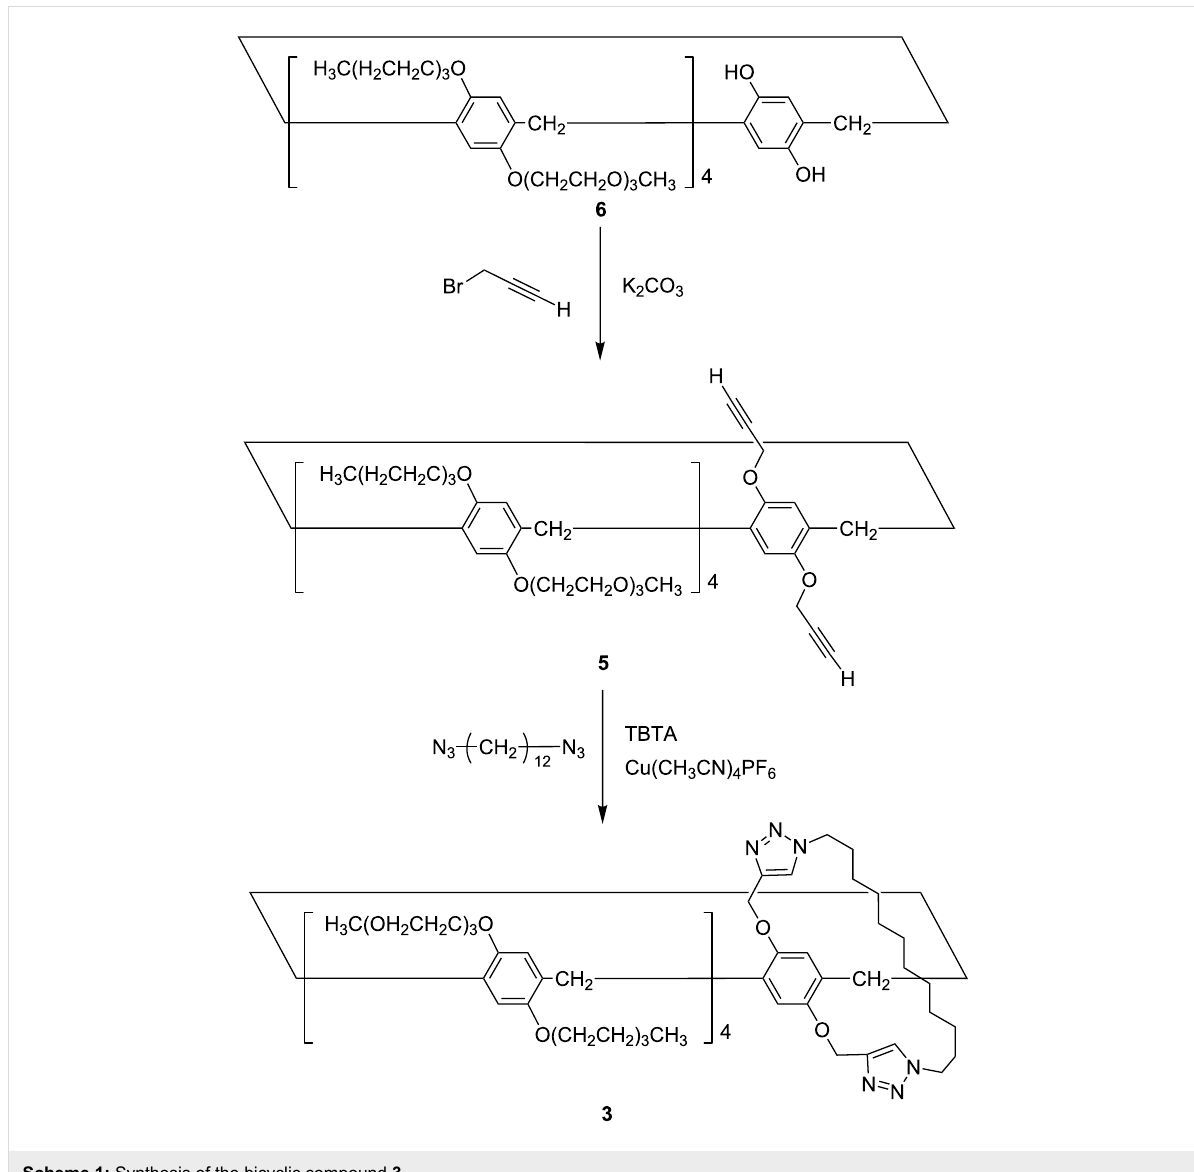
Scheme 1: Synthesis of the bicyclic compound 3